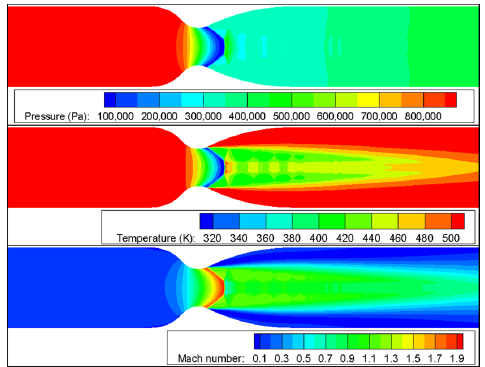
Figure 8. Flow fields for 3D Reynolds ‐ averaged Navier ‐ Stokes equations (RANS): static pressure [Pa], temperature [K], and velocity [m/s].